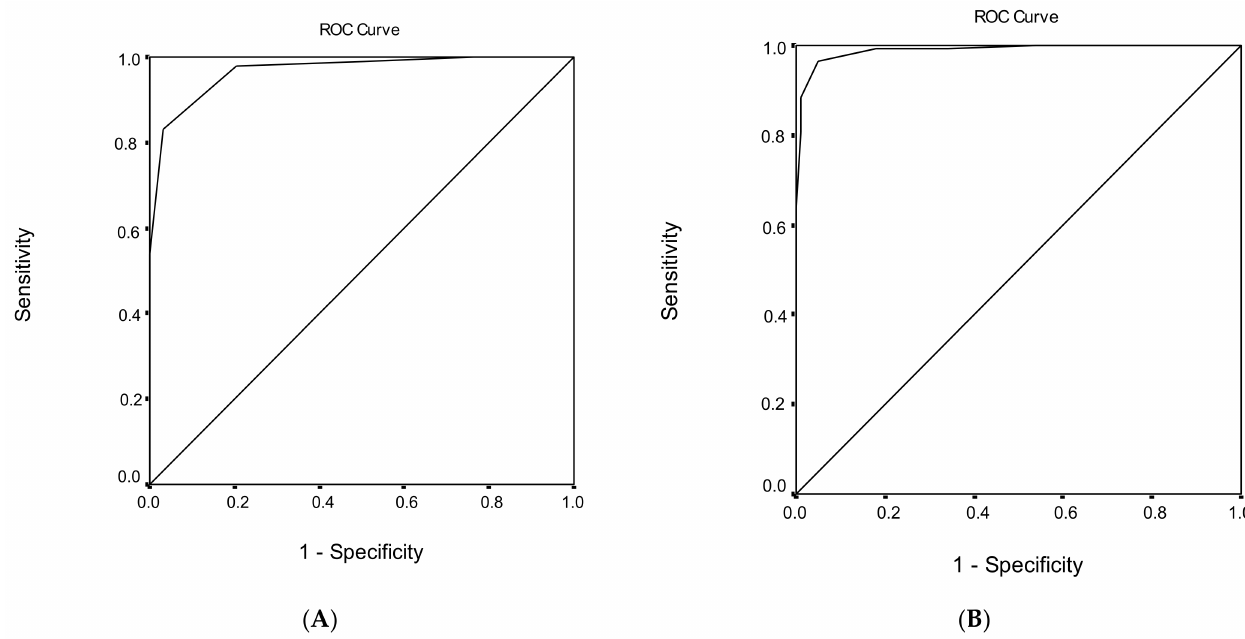
Figure 1. Receiver operating characteristic (ROC) curve analysis of the Montreal Cognitive Assessment (MoCA) to discriminate between ( A ) healthy subjects and mild cognitive impairment (MCI) and ( B ) mild cognitive impairment (MCI) and